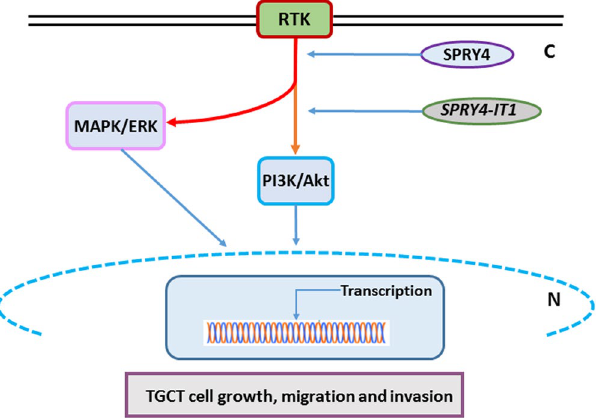
Figure 6. A model for MAPK/ERK and PI3K/Akt activation of SPRY4 and SPRY4-IT1 in TGCT cells. Knockdown of SPRY4 and SPRY4-IT1 results in decreased cell growth, migration, and